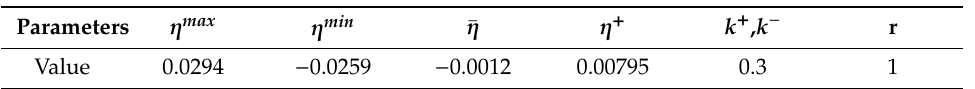
Table 8. The values of the incentive factor-based dynamic comprehensive evaluation (DCE) parameters.